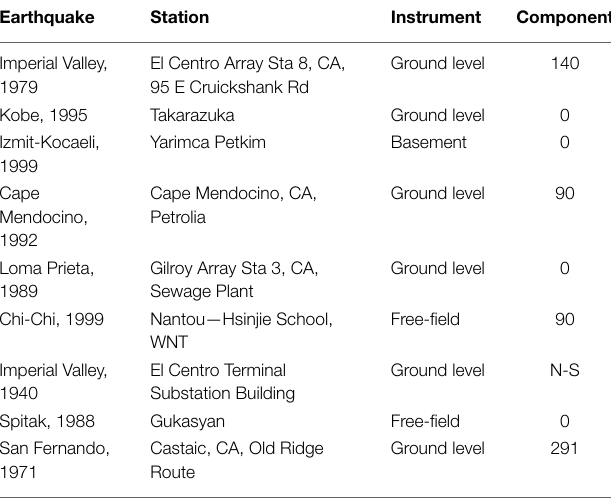
TABLE 1 | Earthquake excitations considered in this study and their